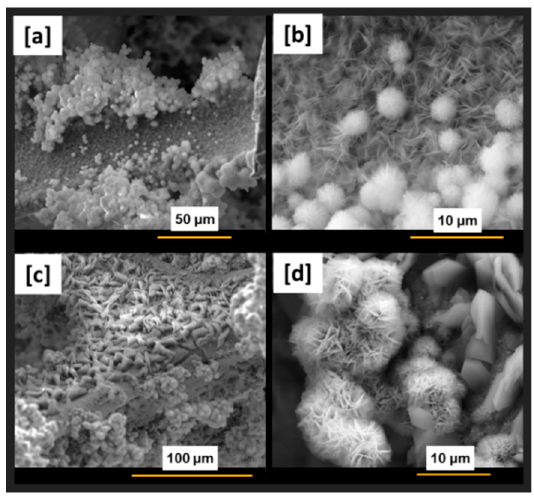
Figure 1. SEM images of ( a , b ) FeNiO and ( c , d )